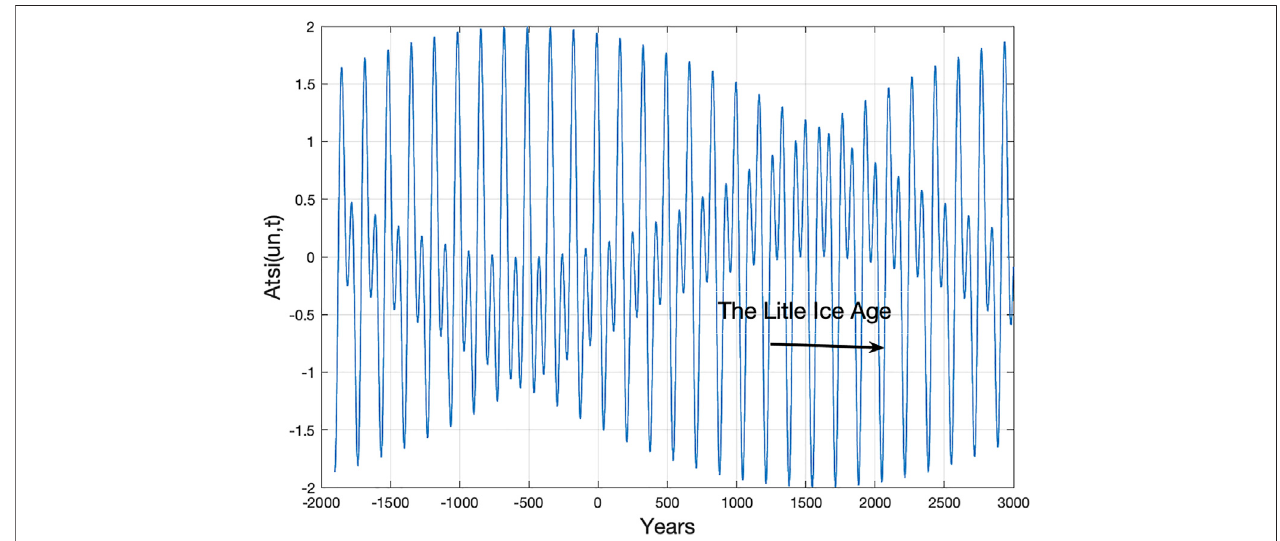
FIGURE1| Constructiveanddestructiveinterference betweenUranus-NeptuneforcedTSIindexvalues,Atsi(un,t)=Atsi(ur,t)+Atsi(ne,t),fortheyears t=( − 2000 ... 3000). “ The Little Ice Age ” covers the six deepest Uranus-Neptune minima